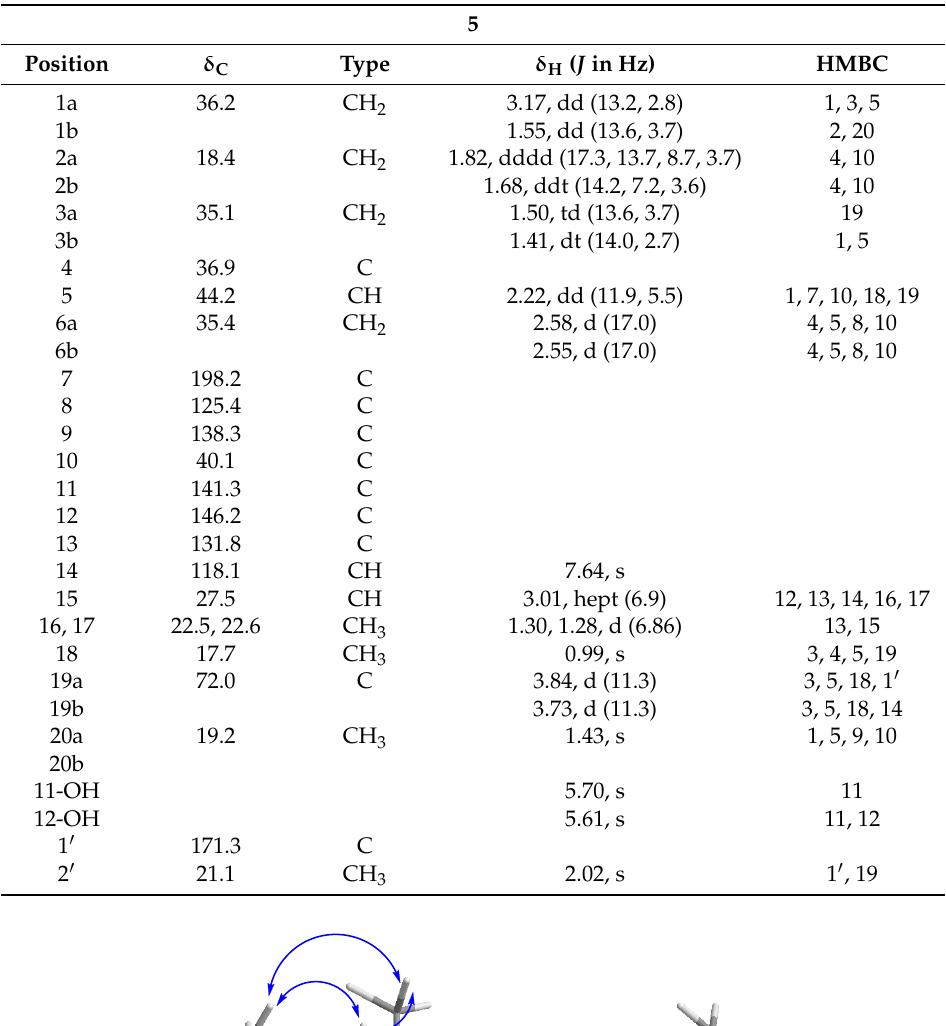
Table 6. NMR data ( 1 H 700 MHz, 13 C 175 MHz, CDCl 3 ) of 5 .